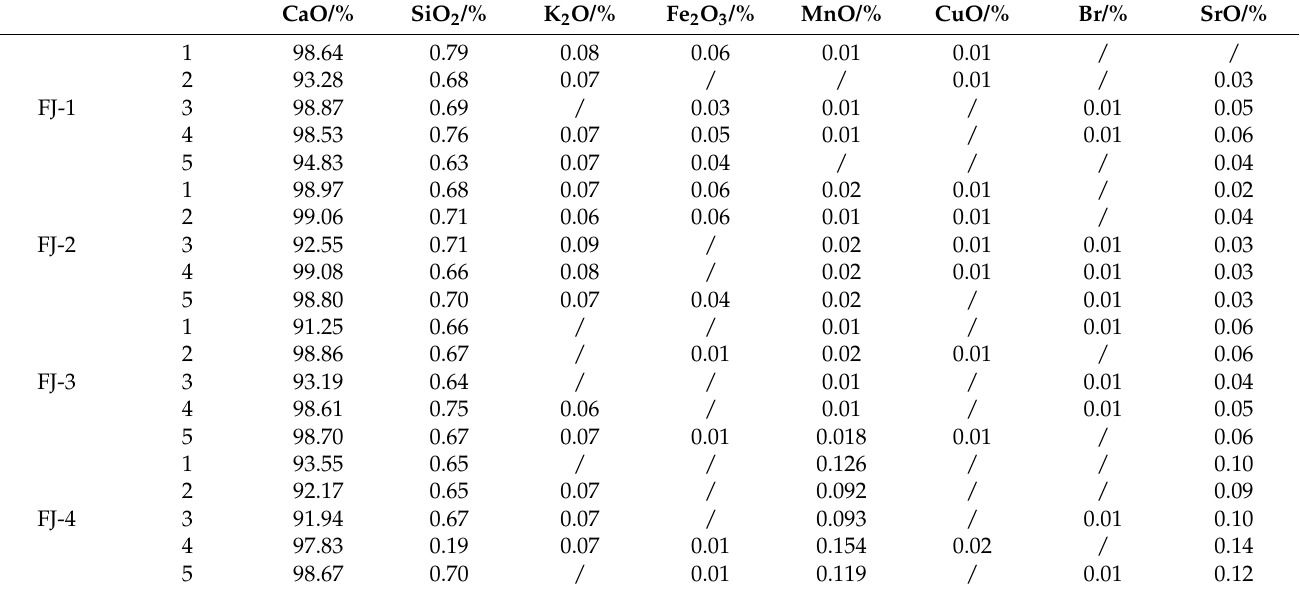
Table A1. Chemical compositions of analyzed calcite from Fujian analyzed by XRF (in wt.%).